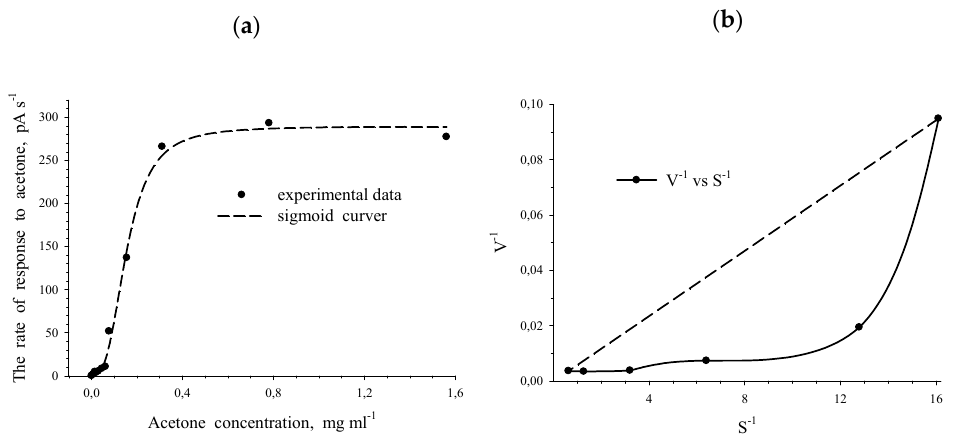
Figure 1. Dependences of the rate of the response (V, pA/c) to acetone on the initial concentration of acetone (S, mg/mL) for acetone-induced R. opacus 1CP cells. ( a ) V vs. S dependence; ( b ) V − 1 vs. S − 1